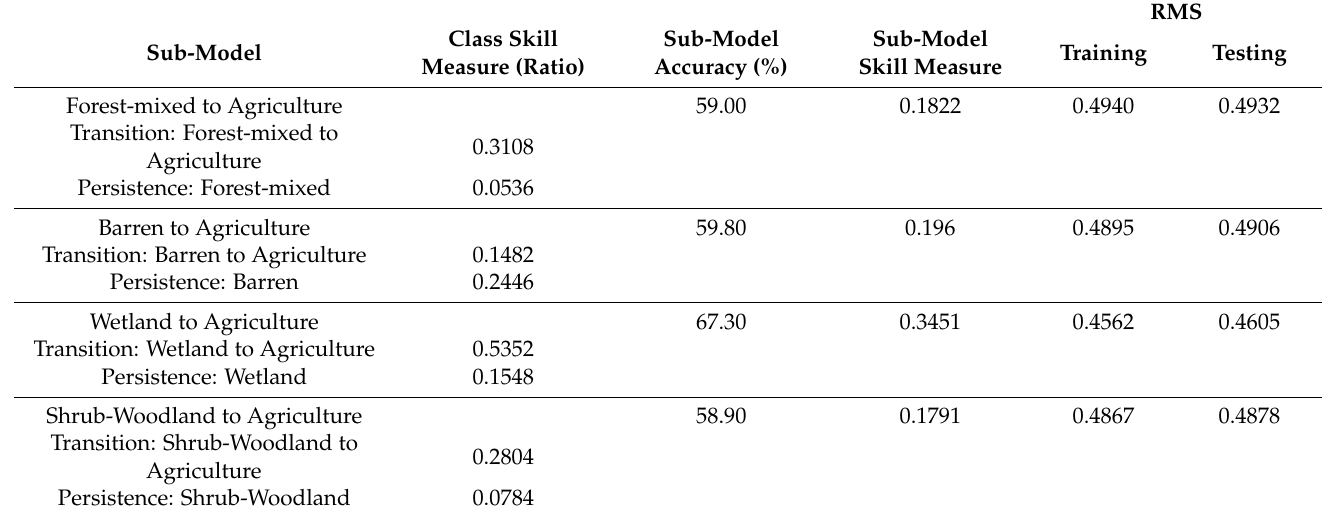
Table 9. Sub models in the Multi-Layer Perceptron (MLP) using six explanatory variables and model performance summary for Ntcheu district (2001–2019).